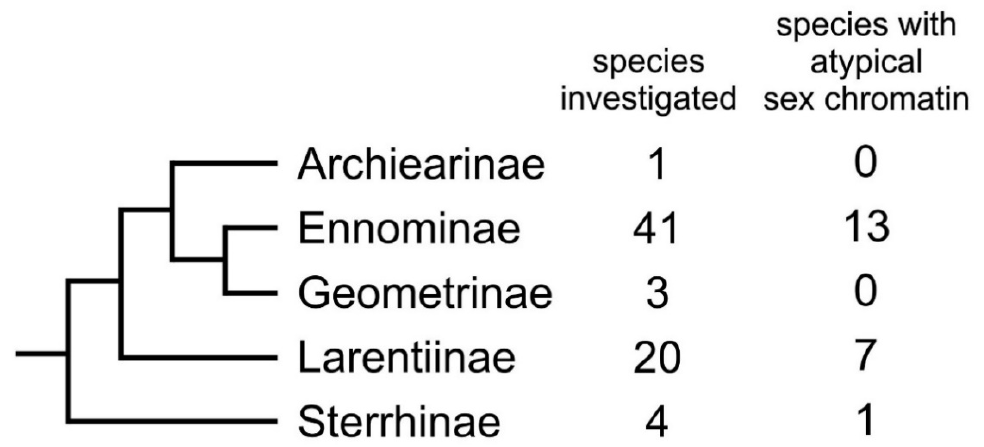
Figure 1. Species inspected for the sex chromatin presence. Data on 69 species of Geometridae belonging to five subfamilies are included. An atypical sex chromatin pattern was found in almost one-third of the species (see Table S1 for details). Phylogeny based on the work of [42].